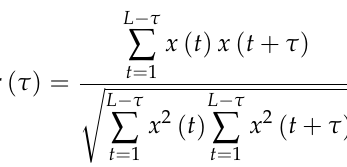
. Figure 3 depicts the evolution of γ av versus ( α , r ) , where the line connects the points with maximum value γ av = max ( γ av )